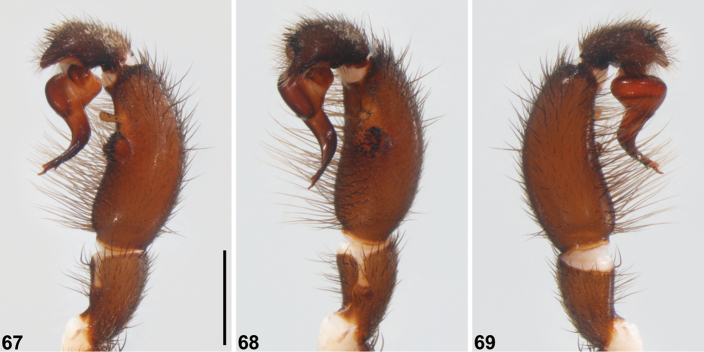

Idiosoma
arenaceum sp. n., male holotype (WAM T139527) from Zuytdorp (Western Australia; GES), pedipalp. 67 Retrolateral view 68 Retroventral view 69 Prolateral view. Scale bar 2.0.